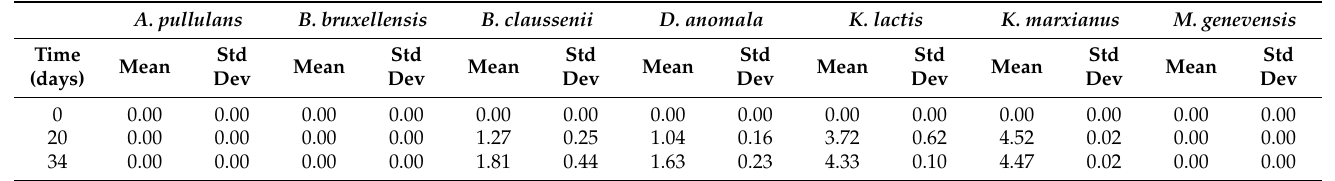
Table 9. Ethanol concentrations under anaerobic fermentation (%).